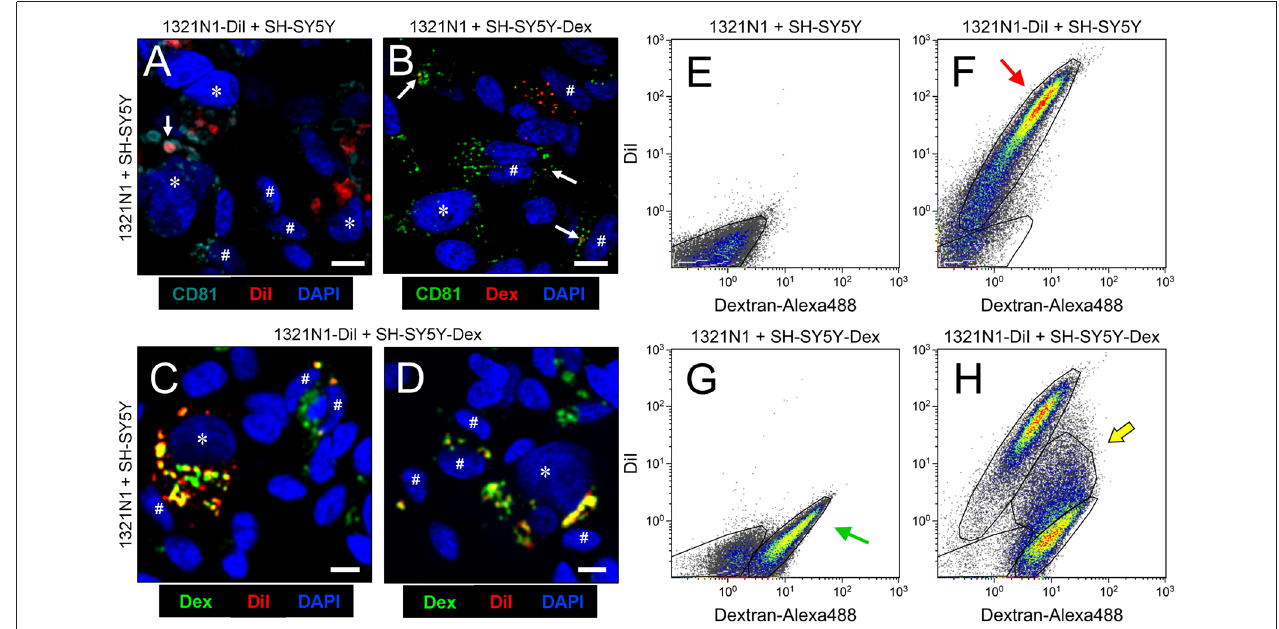
FIGURE 1 | Astrocytes and neurons exchange CD81-positive material. (A–D) Single plane confocal microscopy images extracted from Z-stacks obtained from co-cultures of: 1321N1 astrocytes labeled with DiI and unlabeled SHSY5Y neurons (A) ; unlabeled 1321N1 and SH-SY5Y labeled with Dextran-Alexa 488 (B) ; 1321N1 labeled with DiI and SH-SY5Y labeled with Dextran-Alexa 488. (C,D) Immunocytochemistry with the extracellular vesicle (EV) marker CD81 is shown in (A,B) . Arrows point to colocalizing signals. Asterisks and pound signs mark identified nuclei from astrocytes and neurons respectively. N = 20 confocal stacks/condition. Calibration bars: 10 µ m. (E–H) Flow cytometry analyses plotting the DiI and Dextran-Alexa 488 signals in the different co-culture conditions. The red arrow in (F) indicates the DiI-1321N1 population, and the green arrow in (G) points to the Dextran-Alexa 488-SHSY5Y population. A double labeled cell population appears when both astrocytic and neuronal cells are labeled ( H , marked with a yellow